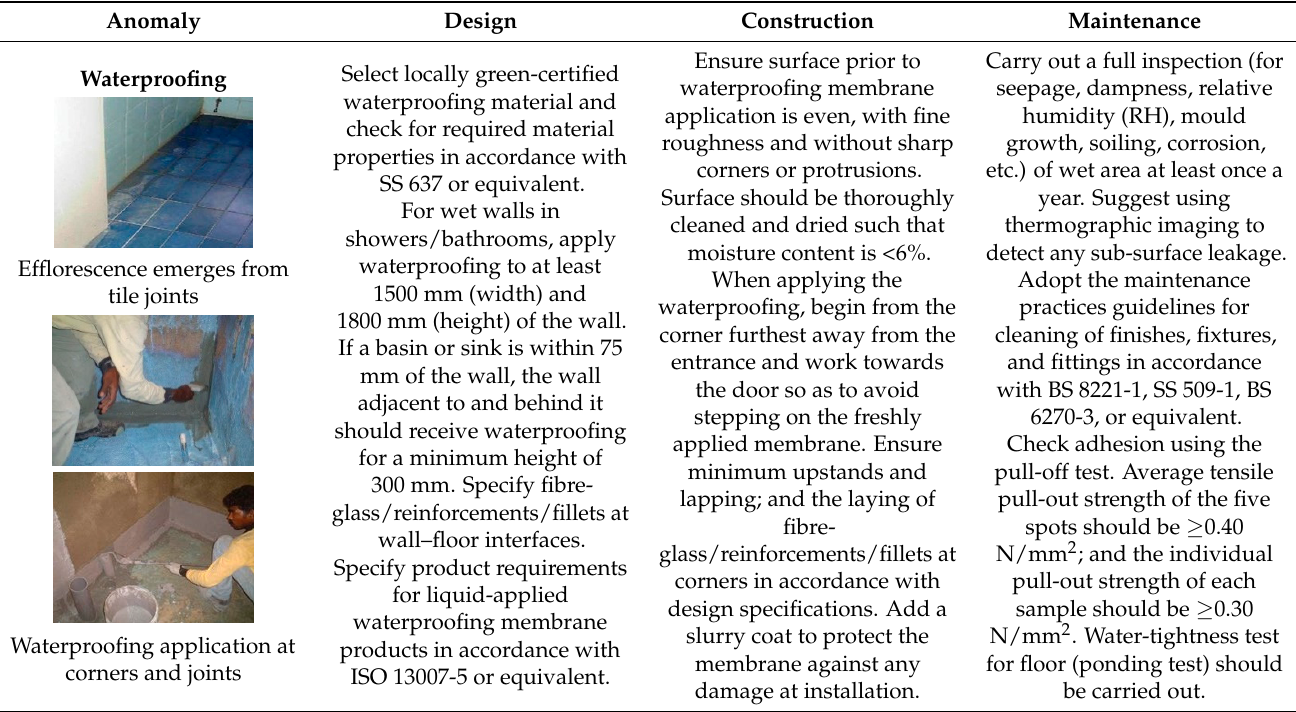
Table 7. Wet Areas—Service components that include vertical and horizontal circulation systems, electro-mechanical connections, and sanitary connections.